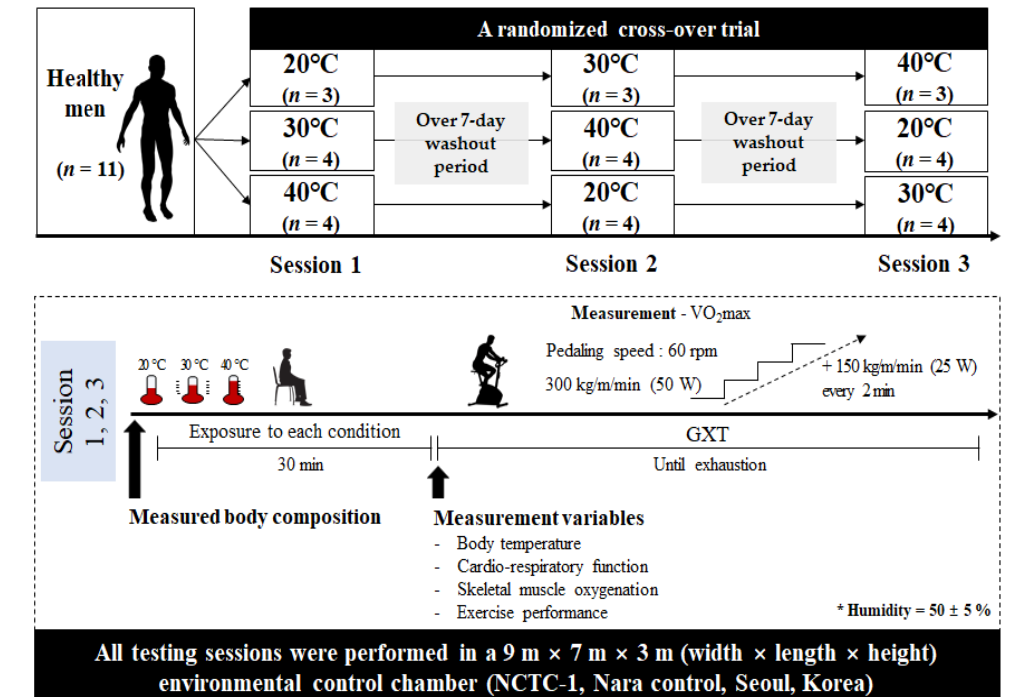
Figure 1. Study design. VO 2 max, maximal oxygen uptake.